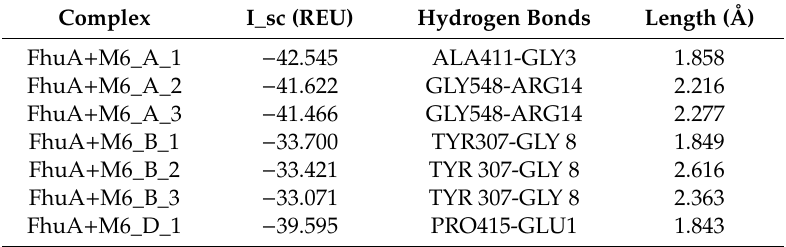
Table 3. Summary of the interface score and hydrogen bonds present in the refined complexes between FhuA and peptide models. In the name of the complexes, the letters A, B, or D represent the selected model in the global docking stage, and numbers 1, 2, or 3 indicate the selected complexes in the refinement